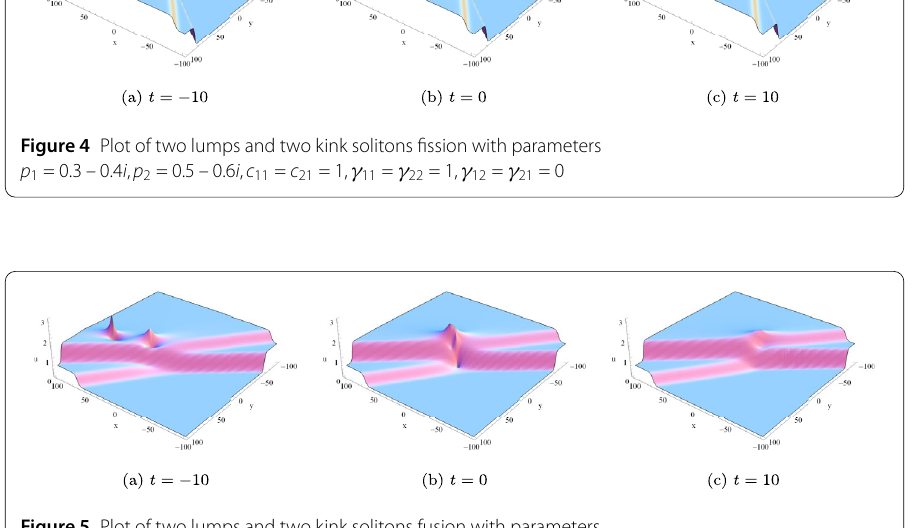
Figure 5 Plot of two lumps and two kink solitons fusion with parameters p